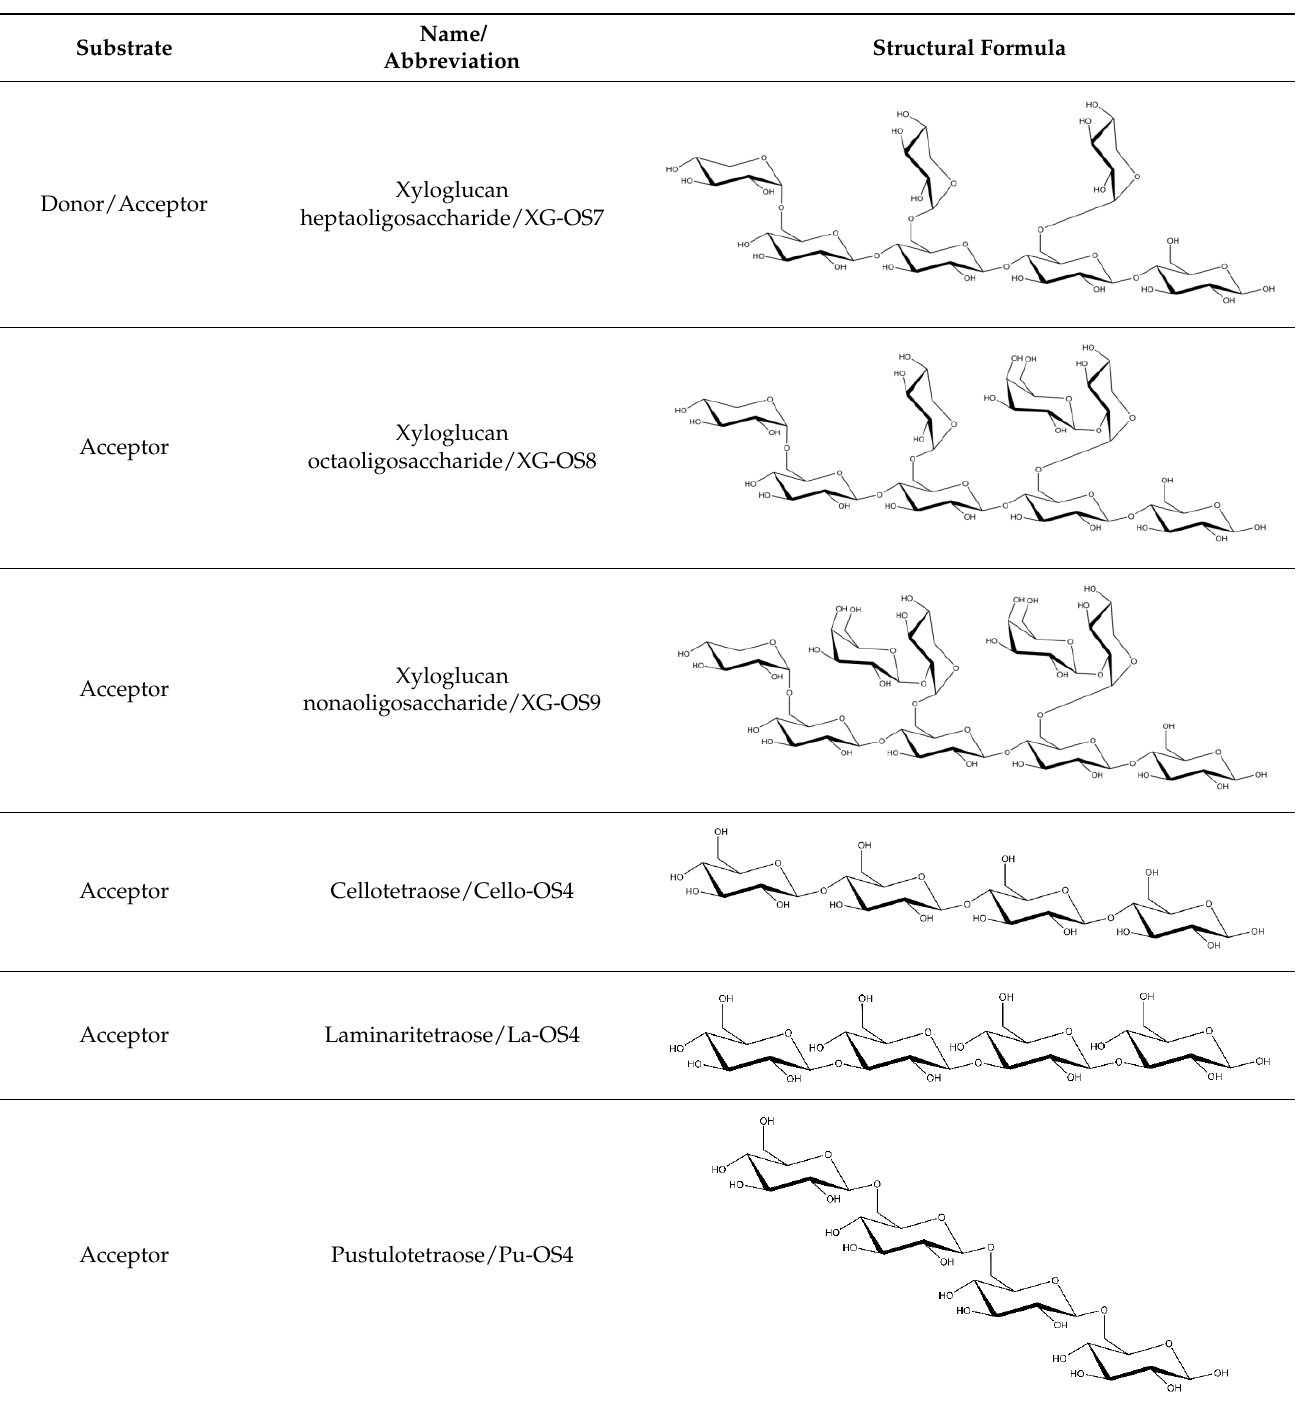
Figure 1. Induced fit docking score parameters of selected acceptor substrates docked into the active sites of TmXET6.3 (bright blue) and PttXET16A (dark blue). Table 1. Abbreviations and structural formulae of the donor and a variety of acceptor oligosaccharide substrates.